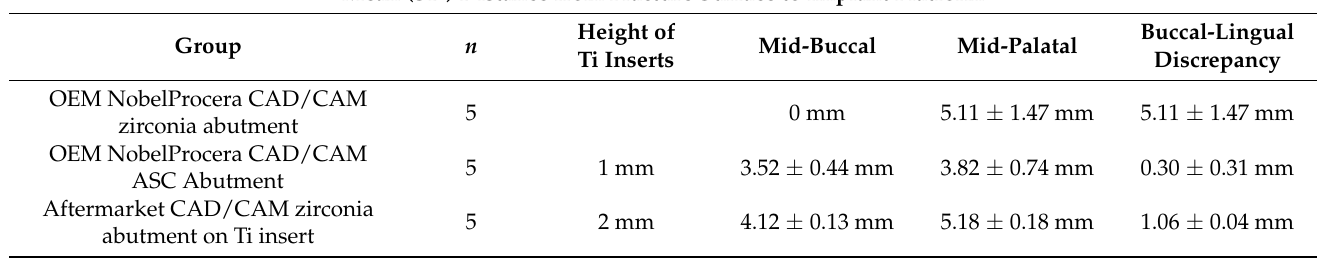
Table 3. Modes of failure and mean distance from fracture surface to implant platform of zirconia abutments.